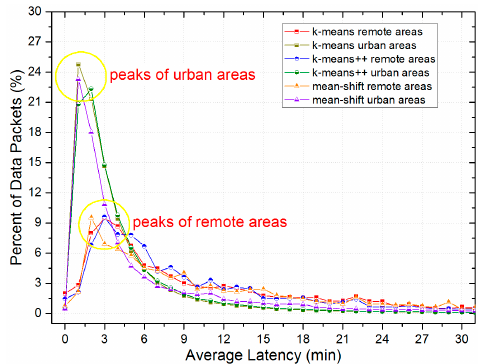
Figure 10. Detailed distribution of the average latency. Sensors 2017 , 17 , 888